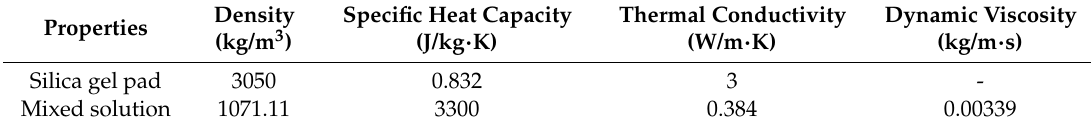
Table 3. Thermal properties of the Silica gel pad and mixed solution.